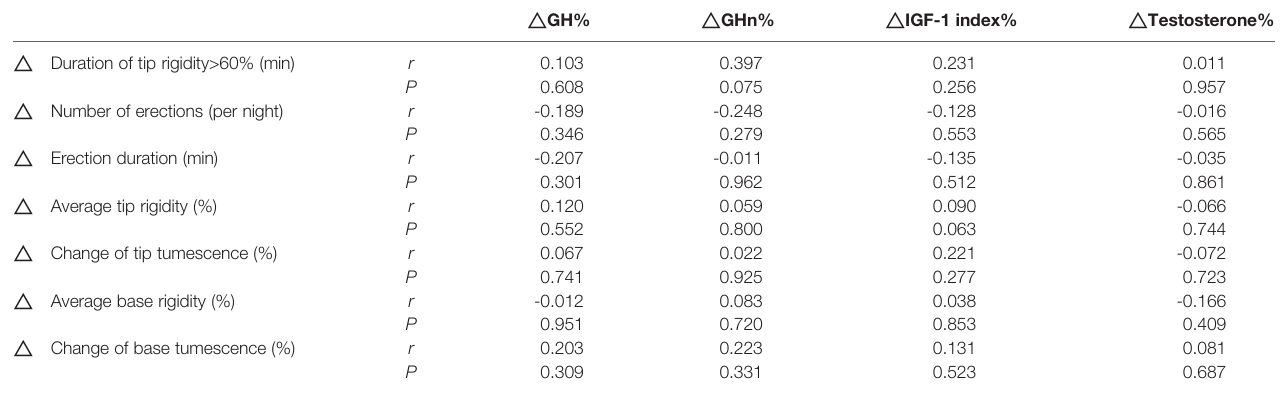
TABLE 7 | Correlation analysis associated with the changes of Rigiscan parameters. △ GH% △ GHn% △ IGF-1 index% △ Testosterone% △ Duration of tip rigidity>60%